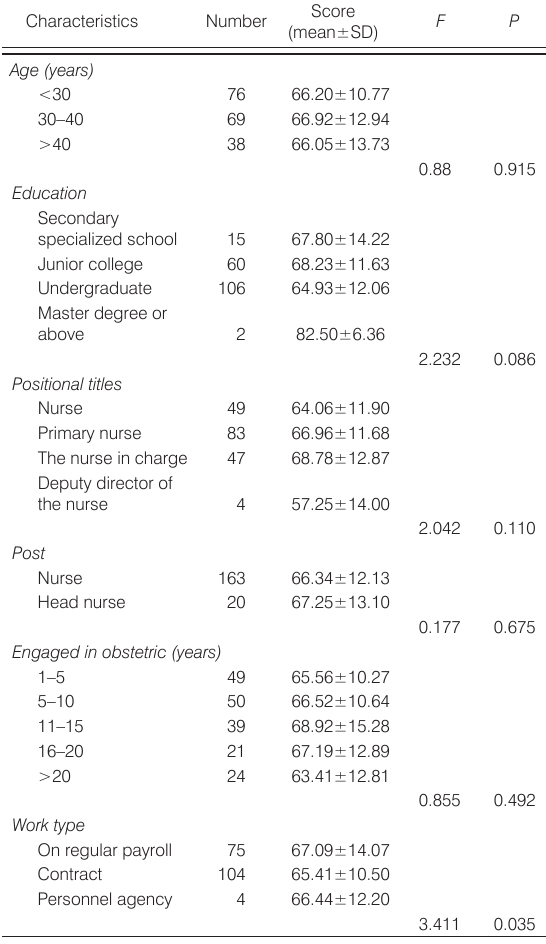
Table 5. Differences of resilience scores among obstetric nurses in general demographic